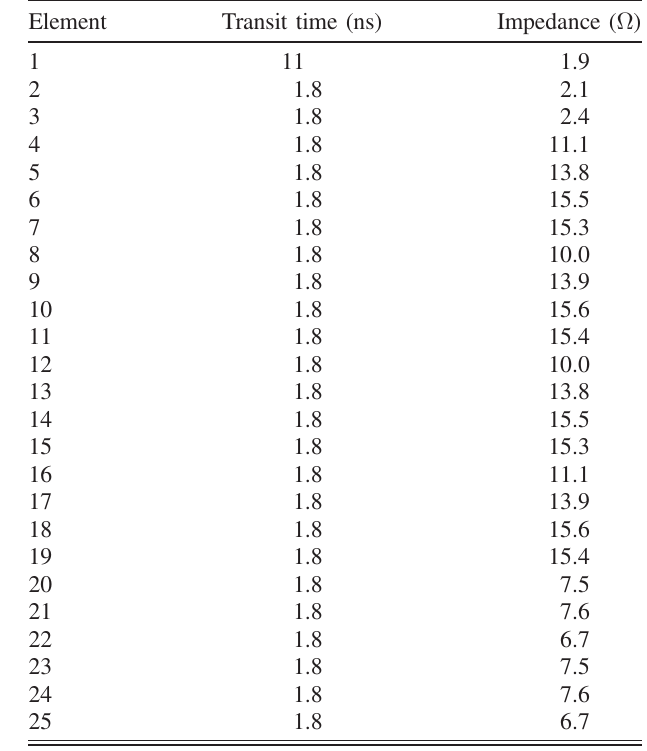
TABLE IV. Transit time in nanosecond and impedance in ohm for the transmission line elements in the water